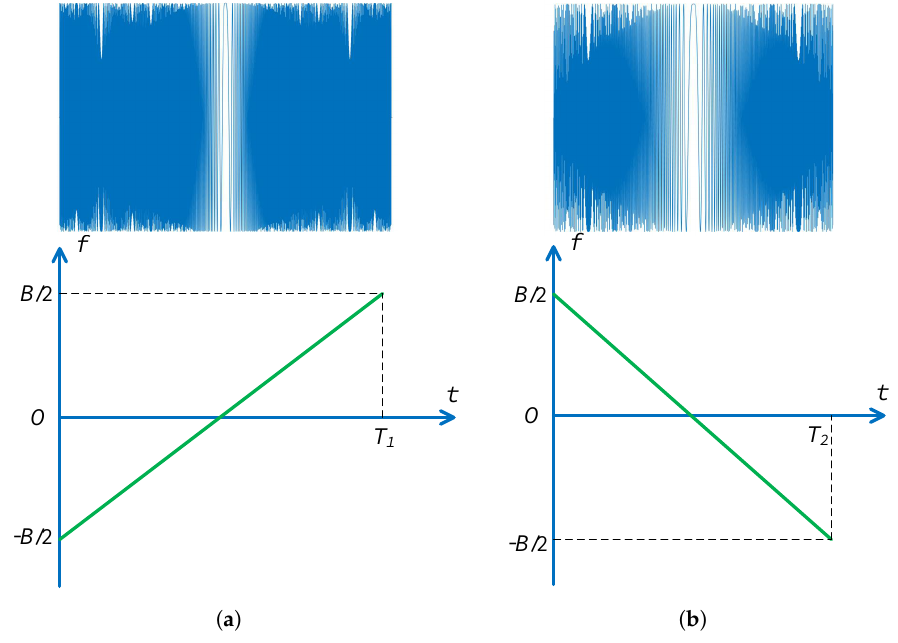
Figure 6. ( a ) Up chirp. ( b ) Down